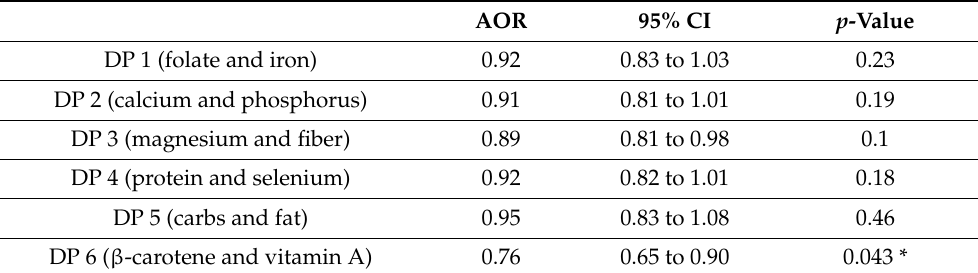
Table 6. Subgroup classified as frail by FI and robust by FP—multiple logistic regression analyses a examining the association of dietary patterns with frailty in adults with